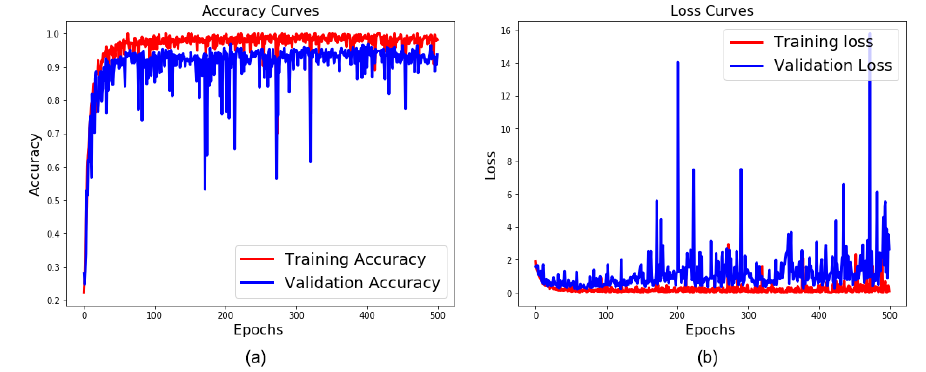
Figure 7. ( a , b ) Accuracy curve and loss curve with RIA-DCNN facial expression recognition.